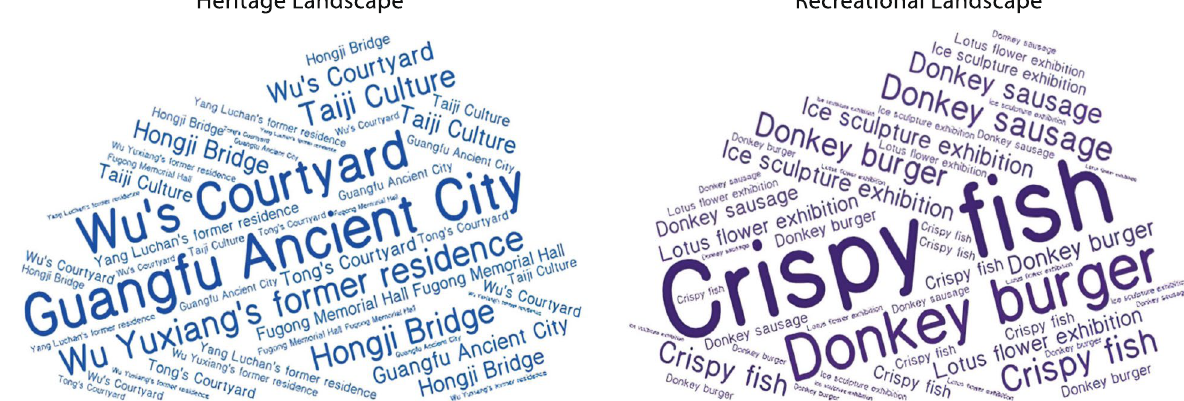
Fig. 5 Word cloud analysis of tourist reviews of Guangfu Ancient City (Source: the